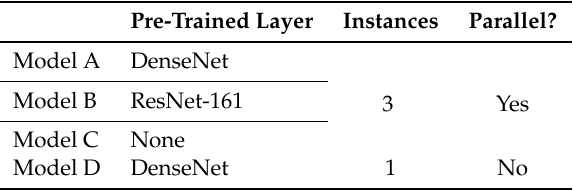
Table 3. Network variants experimented.